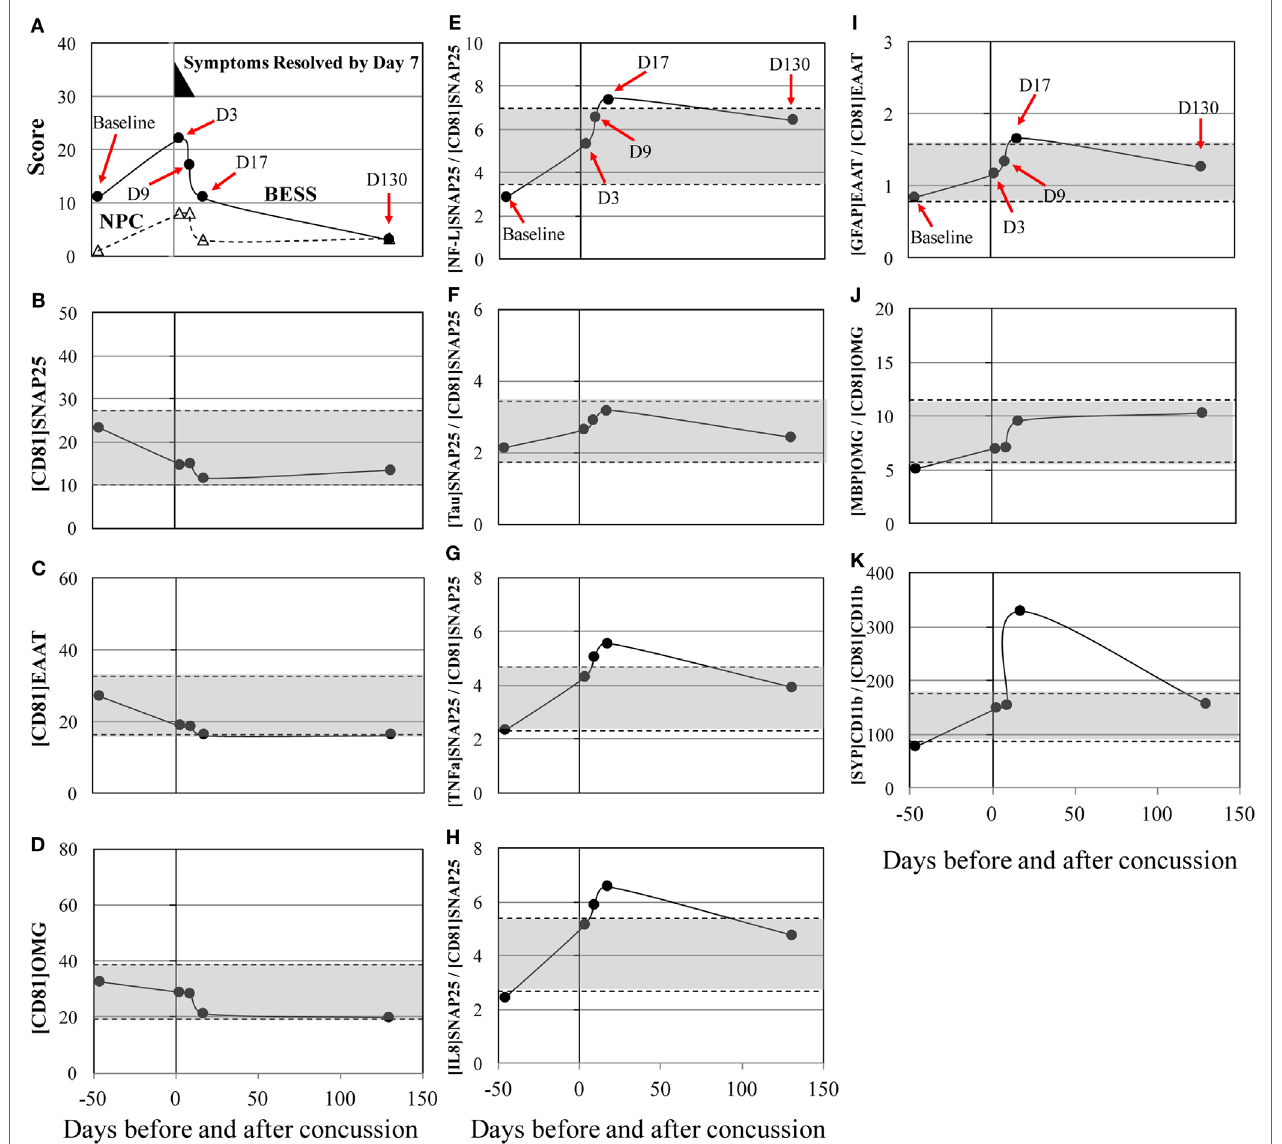
FigUre 1 | Concussion case 1: transient symptoms. X axis is days before and after concussion, with day 0 being the day of concussion. (a) : clinical assessment of balance error scoring system (BESS) ( ● ) and near point of convergence (NPC) ( Δ ). (B) : [CD81] SNAP25 + (U/mL), (c) : [CD81] EAAT1 + (U/mL), (D) : [CD81] OMG + (U/mL), (e) : [NF-L] SNAP25 + /[CD81] SNAP25 + ratio, (F) : [Tau] SNAP25 + /[CD81] SNAP25 + ratio, (g) : [TNF α ] SNAP25 + /[CD81] SNAP25 + ratio, (h) : [IL8] SNAP25 + /[CD81] SNAP25 + ratio, (i) : [GFAP] EAAT1 + / [CD81] EAAT1 + ratio, (J) : [MBP] OMG + /[CD81] OMG + ratio, and (K) : [SYP] CD11b + /[CD81] CD11b + . ± 50% from pre- and post-season average values was shown in shaded blanket as referential values. SNAP25, synaptosome-associated protein 25, NF-L, neurofilament light polypeptide; TNF α , tumor necrosis factor-alpha; IL8, interleukin-8; EAAT1, excitatory amino acid transporter 1; GFAP, glial fibrillary acidic protein; OMG, oligodendrocyte myelin glycoprotein; MBP, myelin basic protein; SYP,